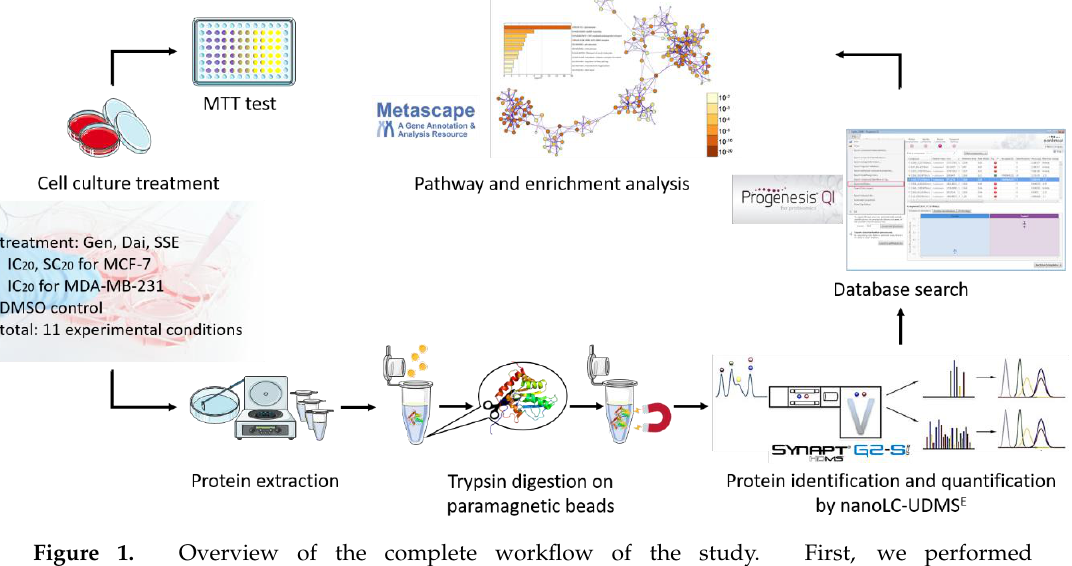
Figure 1. Overview of the complete workflow of the study. First, we performed 3-(4,5-dimethylthiazol-2-yl)-2,5-diphenyltetrazolium bromide (MTT) assay to assess the cytotoxic or stimulatory potential of genistein (Gen), daidzein (Dai), and the soy seed extract (SSE). Second, we subjected MCF-7 and MDA-MB-231 breast cancer cells exposed to different concentrations of isoflavones to protein extraction, trypsin digestion of proteins using paramagnetic beads and nano-liquid chromatography-ultra definition mass spectrometry (nanoLC-UDMS E ) analysis for protein identification and quantification. Database search combined with statistical and bioinformatical analysis allowed us the identification of most affected signaling pathways and processes. SC 20 , IC 20 : concentrations of Gen, Dai, and SSE that induced a 20% growth stimulation or inhibition, respectively, compared to control.